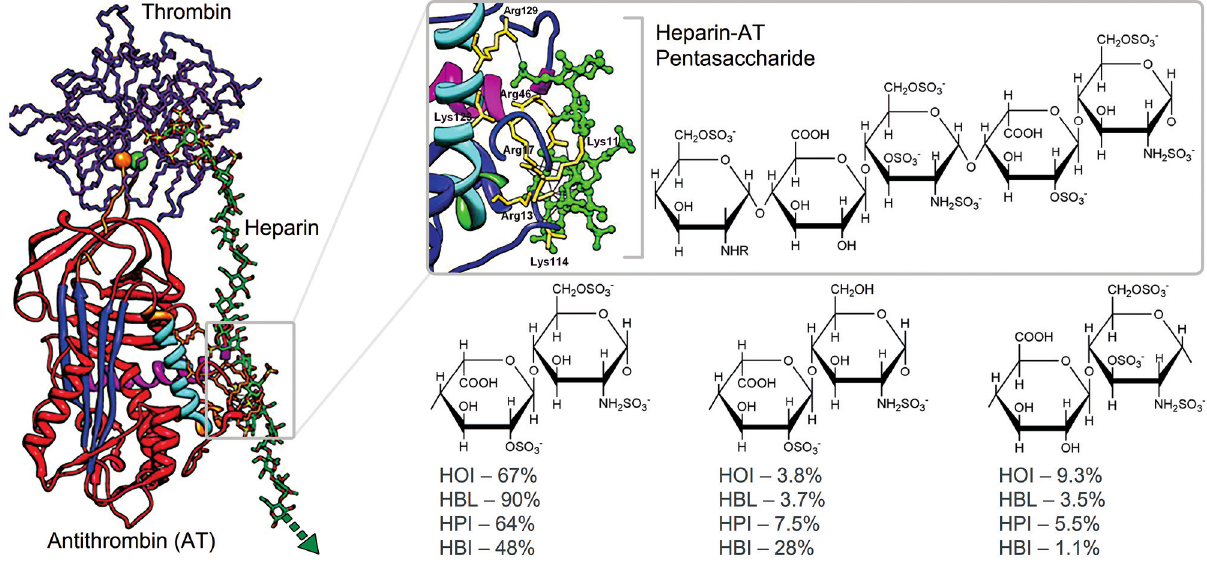
Fig. 1 Heparin-antithrombin interaction and compositional differences among heparins produced from distinct animal sources. Interaction of heparin with antithrombin is mediated by a speci fi c pentasaccharide sequence. Heparins from distinct animal sources, such as porcine (HPI), bovine (HBI) and ovine (HOI) mucosa and bovine lung (HBL), can present notable differences in the proportion of some of their disaccharide constituent units; for example: 2-sulfated α -L-iduronic acid 1 ! 4 N ,6-disulfated α -D-glucosamine; 2-sulfated α -L-iduronic acid 1 ! 4 N -sulfated α -D-glucosamine and β -D-glucuronic acid 1 ! 4 N ,3,6-trisulfated α -D-glucosamine.